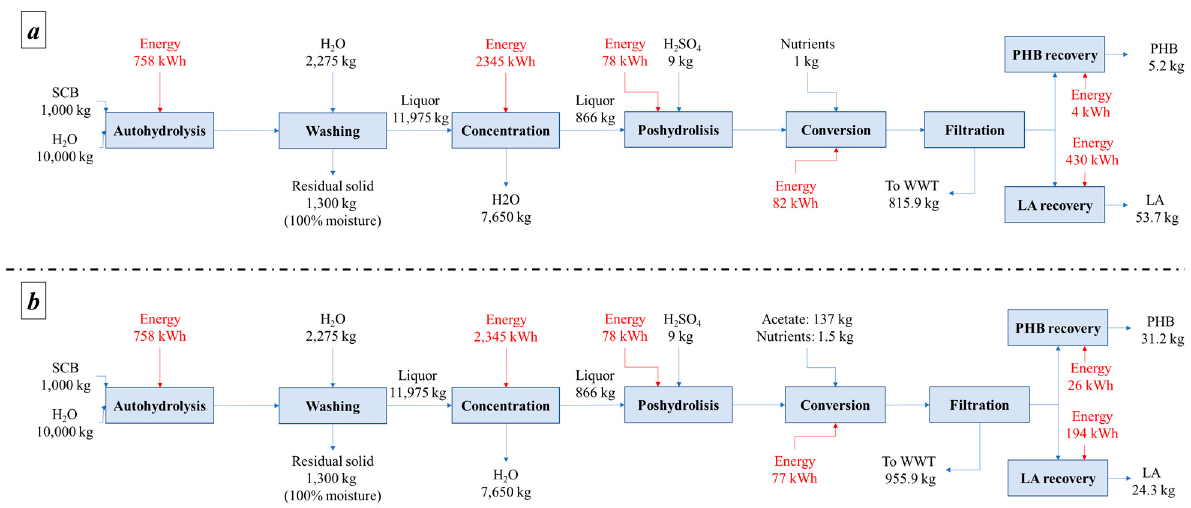
Figure 3. Mass and energy balances for the SCB valorization strategy ( a ) without acetate and ( b ) with acetate.